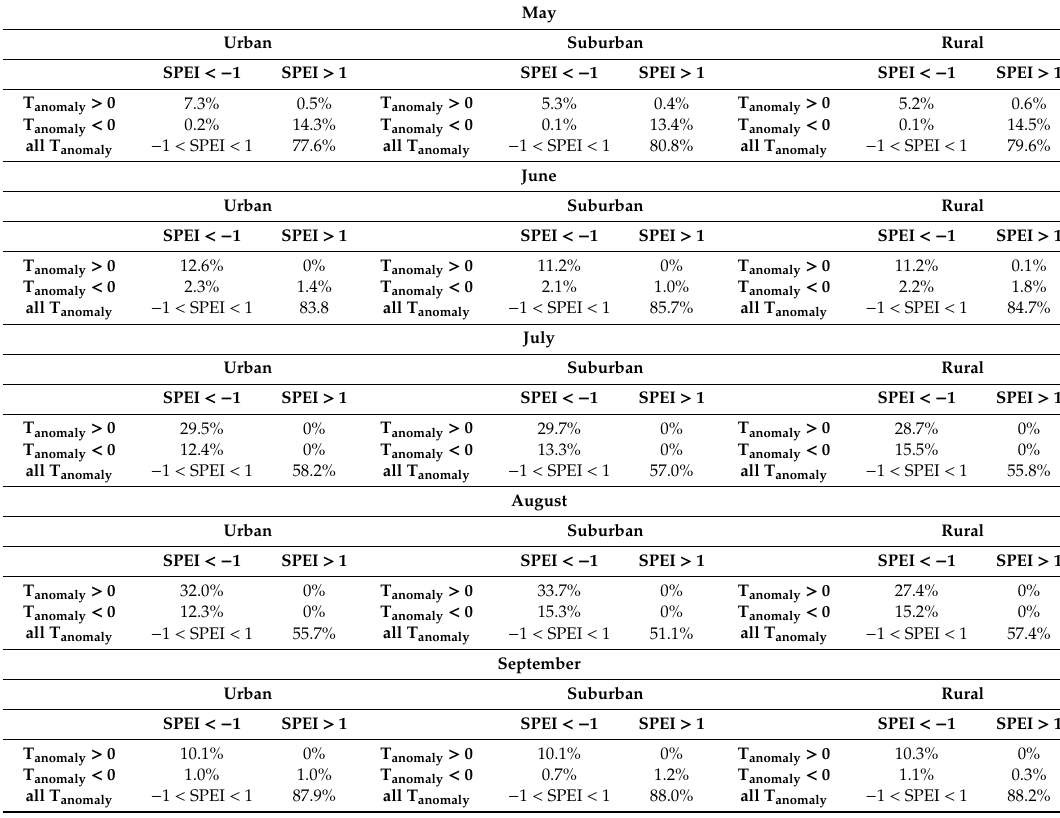
Table 5. Percentage of occurrence of T anomalies for each station under wet conditions (SPEI > 1), dry conditions (SPEI < − 1), and normal climatic conditions ( − 1 < SPEI <